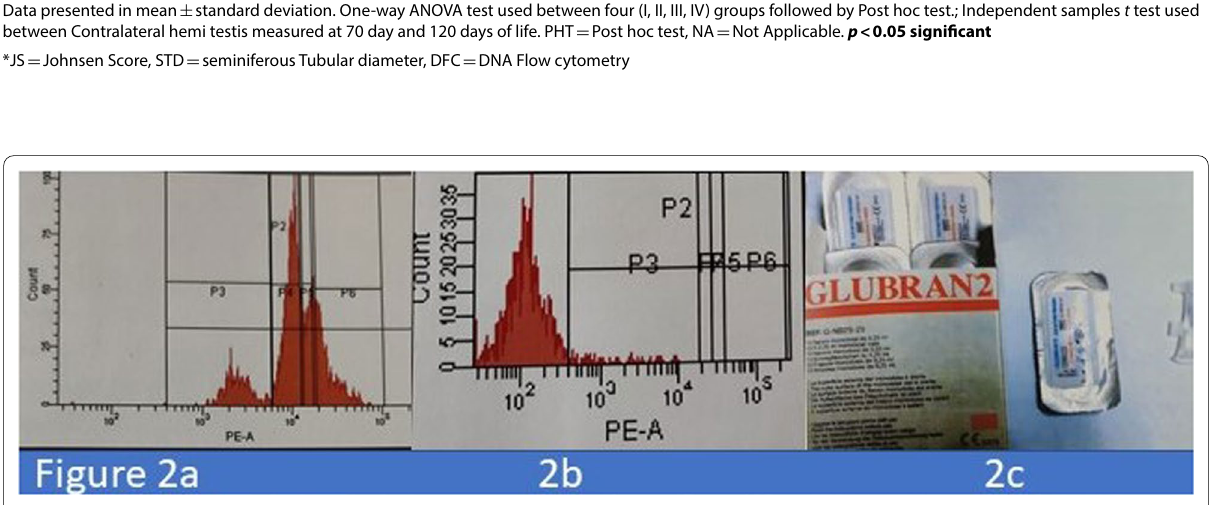
Fig. 2 a Group I haploid cell population percentage. b Group III haploid cell population percentage. c Tissue Adhesive Glubran